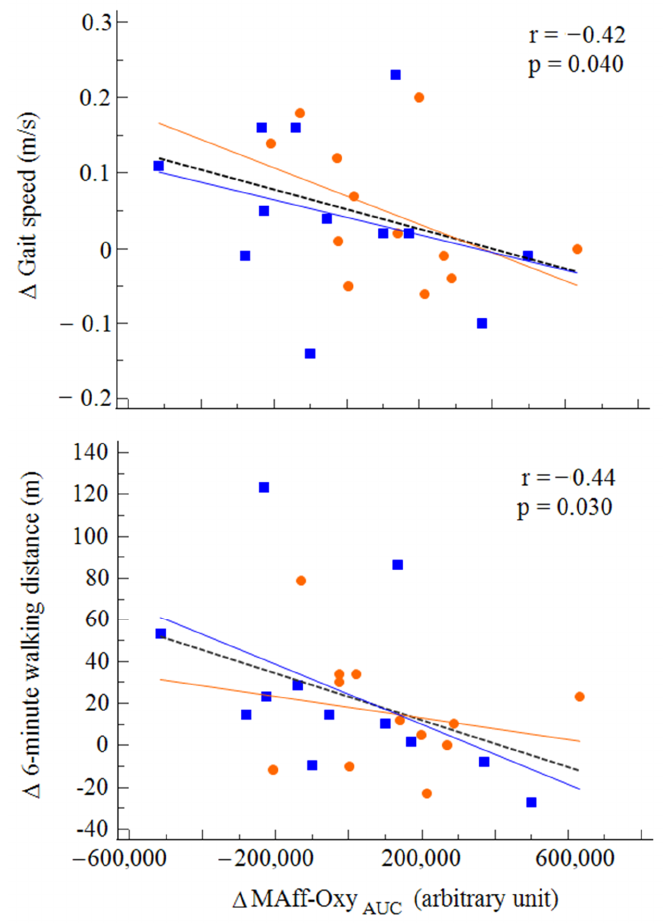
Figure 5. Correlations between variations in cortical activation within the more affected hemisphere and variations in gait speed and walking ability after rehabilitation among the two groups (OW: orange; RAGT: blue).